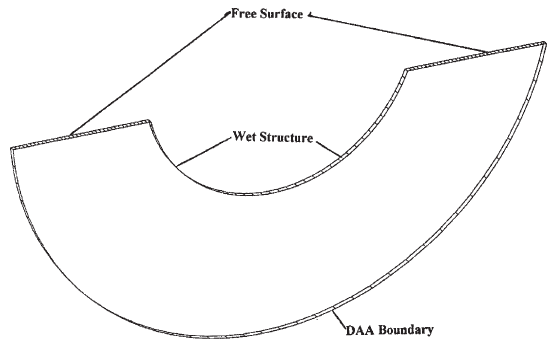
Fig. 9. DAA boundary, free surface and fluid-structure interface. (cid:15) maximum number of fluid volume nodes 8 (cid:15) maximum number of face element nodes 4